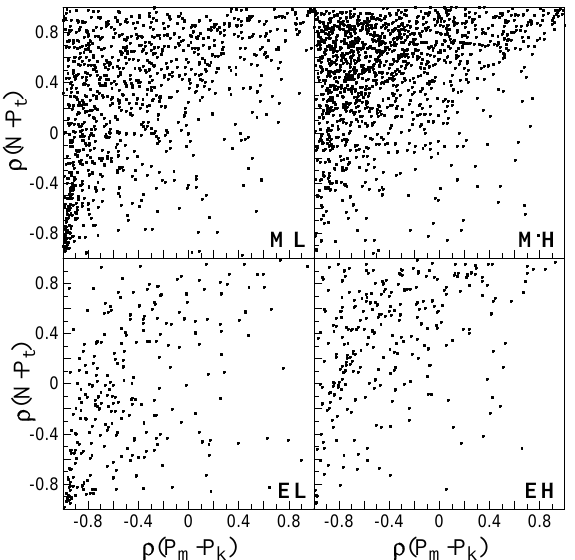
Fig. 8. Scatter plots of ρ(B − N) vs. ρ(B − T ) for mid- and low- latitude samples M and E, separately for low (L) and high (H) speed